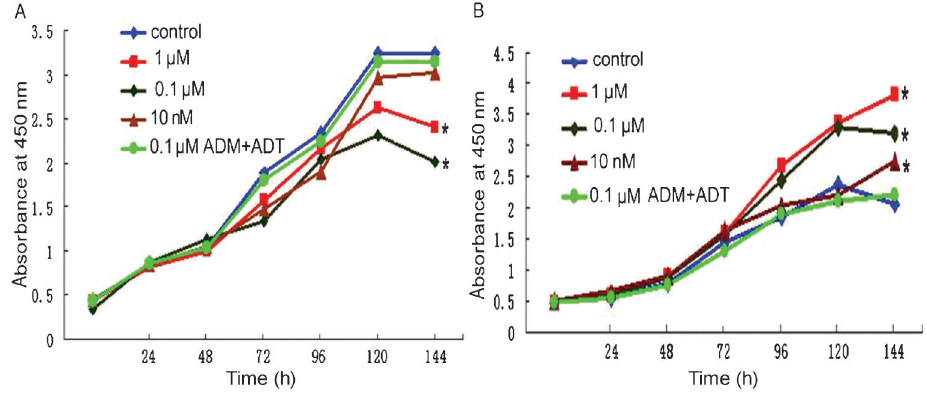
Figure 3. Proliferation curve of cultured PASMCs by the CCK8 test. A , Increasing concentrations of ADM or 0.1 m M ADM++ADT. B , Increasing concentrations of ADT or 0.1 m M ADM++ADT. PASMCs: pulmonary arterial smooth muscle cells; ADM: adrenomedullin; ADT: adrenotensin. Data are reported as mean±SE absorbance for n=6 rats per group. *P , 0.05 vs control (one-way ANOVA).